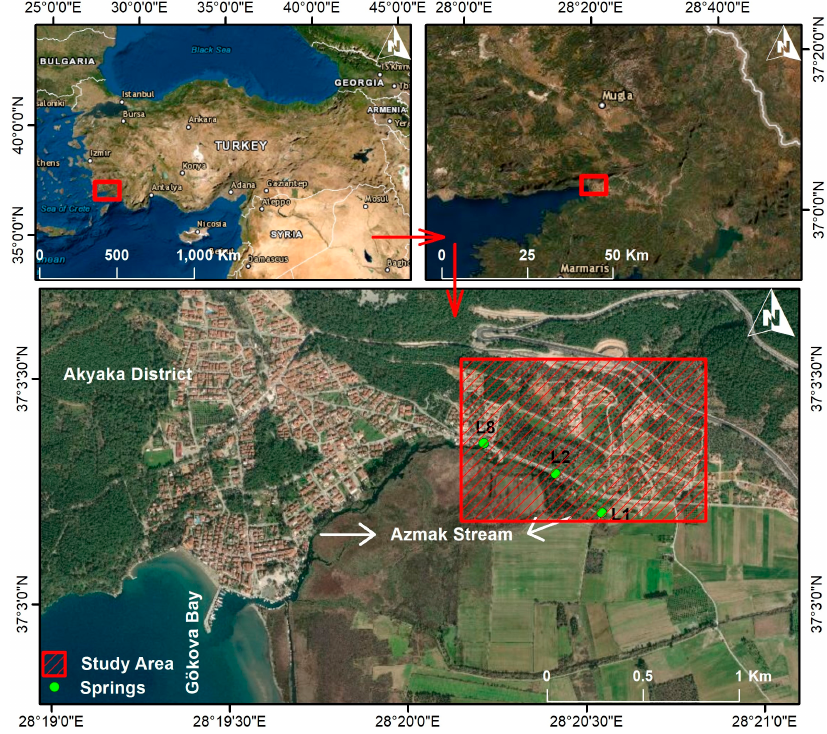
Figure 1. Location map: Gökova Bay, Akyaka District, Azmak Springs, Azmak Stream, and the geophysical study area.